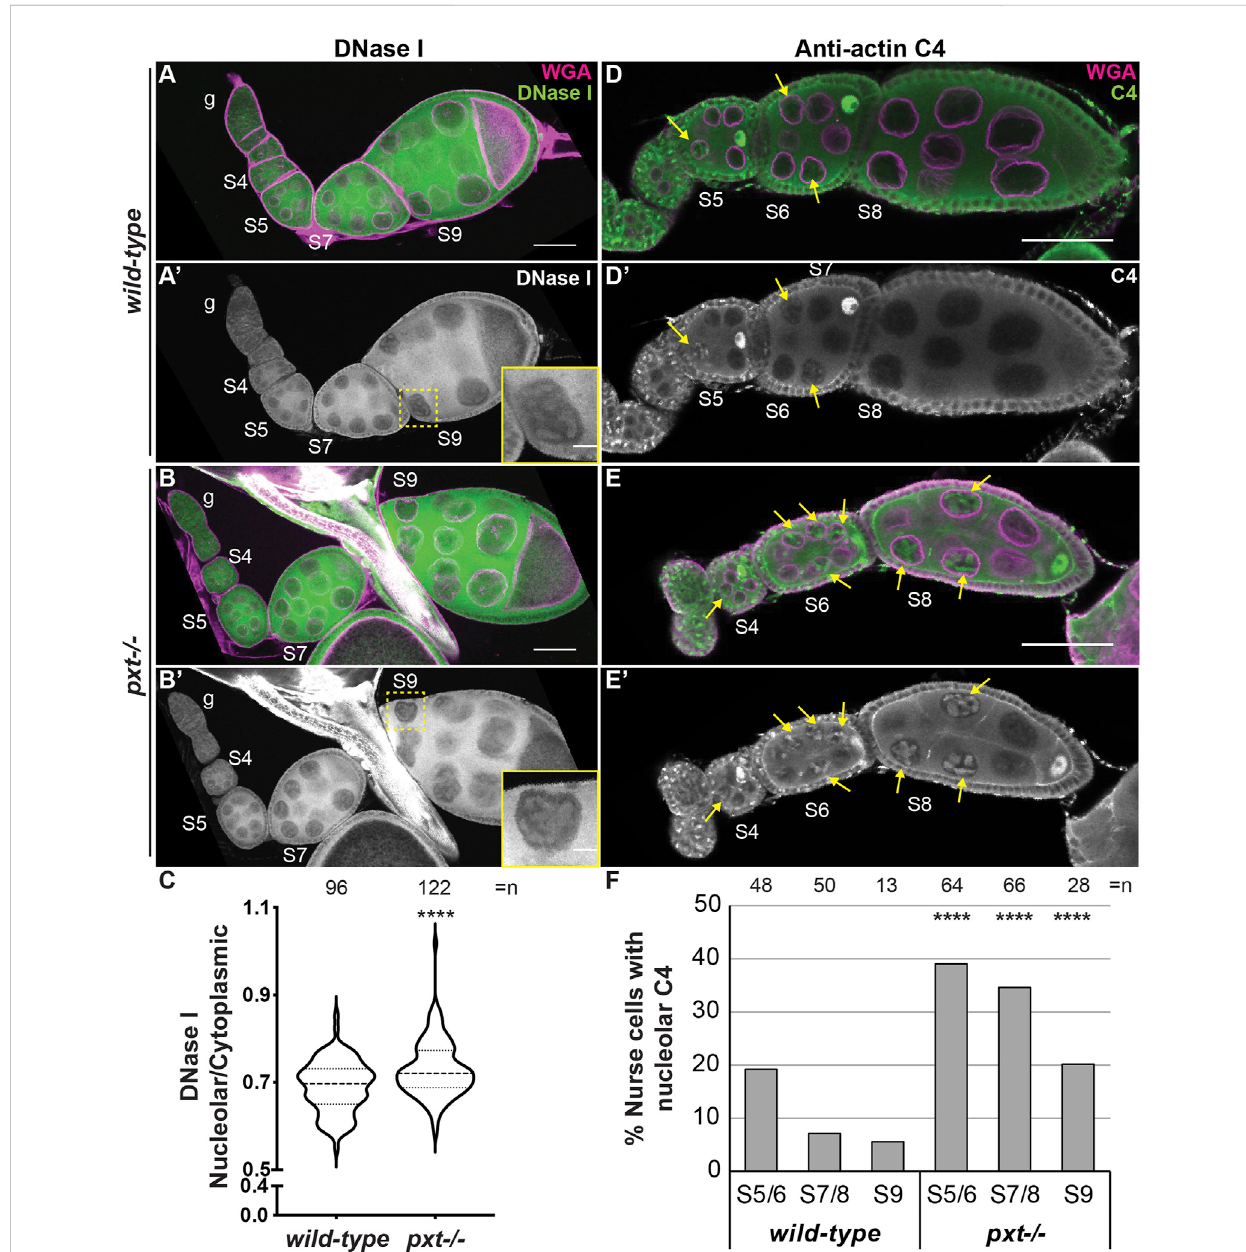
(D-E 9 ) ingreeninmergeandwhiteinsinglechannel.In (A 9 ,B 9 ) ,yellowdashedboxindicatesnursecellininset.In (D-E 9 ) ,yellowarrowsindicateC4positive nursecellnucleoli.Scalebars=50 μ m,except ininsetwherescale bars=10 μ m. (C) .GraphquantifyingtheratioofnucleolartocytoplasmicDNaseI fl uorescence intensity in S7/8 follicles, **** p < 0.0001 (unpaired t-test with Welch ’ s correction). n = number of nurse cells; three nurse cells were measuredperfollicle. (D) .GraphquantifyingthepercentageofnursecellsinS5/6,S7/8,andS9withC4nucleolar staining,**** p < 0.0001(Pearson ’ sChi- squared test). n = number of follicles. In (C,D) , data from both pxt alleles were combined. Loss of Pxt results in increased nucleolar DNase I levels (A – C) , and an increased frequency of C4 positive nurse cell nucleoli (D – F)